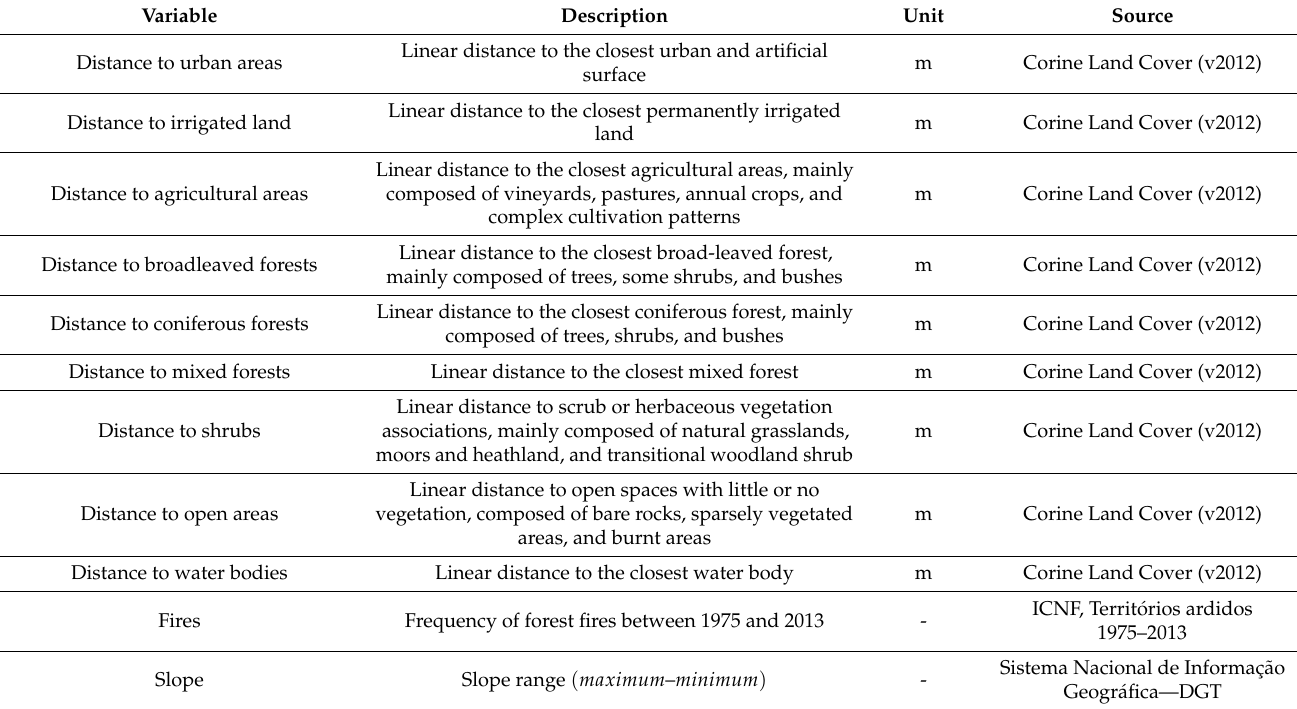
Table 1. Description, units, and source of the eleven environmental